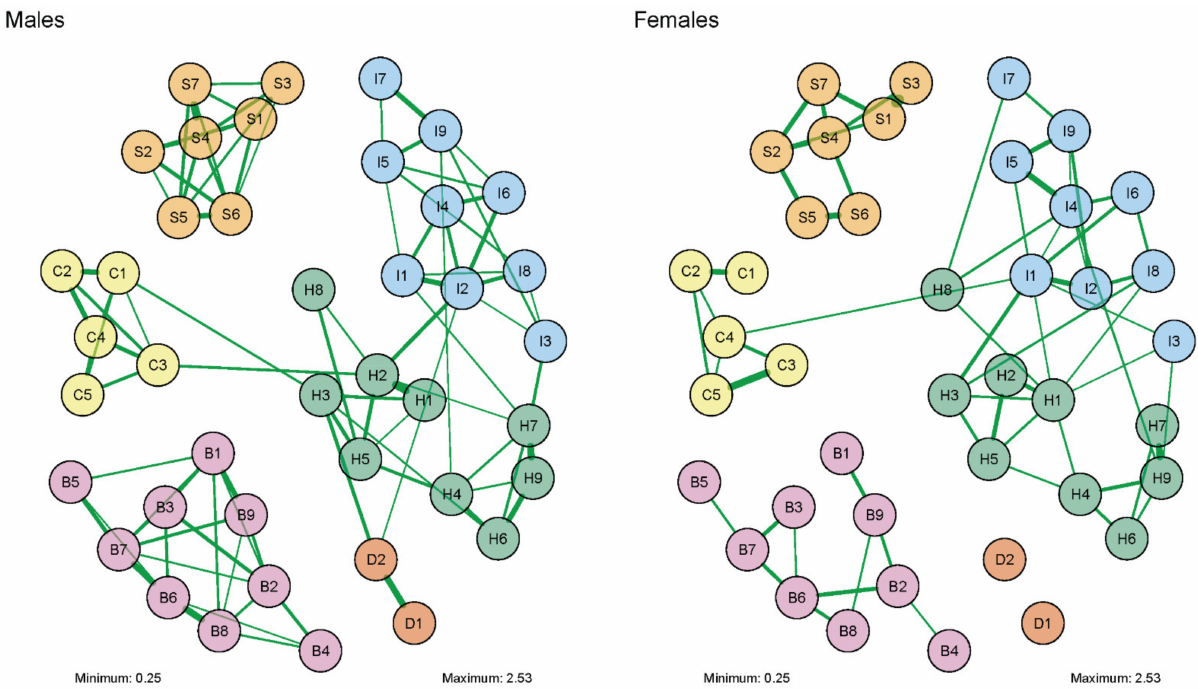
Figure 2. Comparison of two network structures of 41 DSM symptoms of SUD, ADHD, CD, MDD, and BPD (IsingFit). Description of each symptom (node) is presented in Table